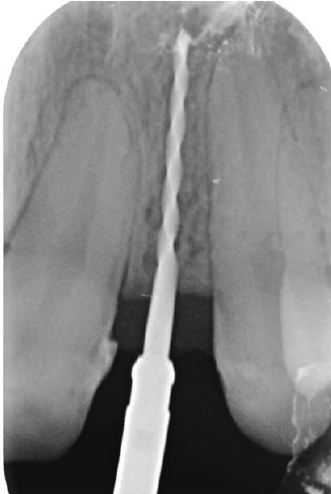
Figure 8: Radiographic examination of the correct inclination in site to the right.